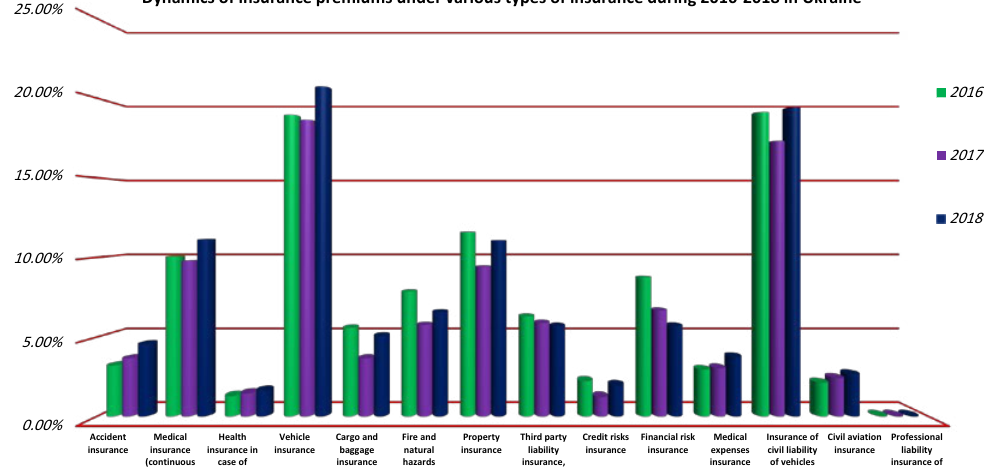
Fig. 1: Dynamics of insurance premiums under various types of insurance during 2016-2018 in Ukraine Table 2: Analysis of insurance reimbursement under various types of insurance during 2016-2018 in Ukraine